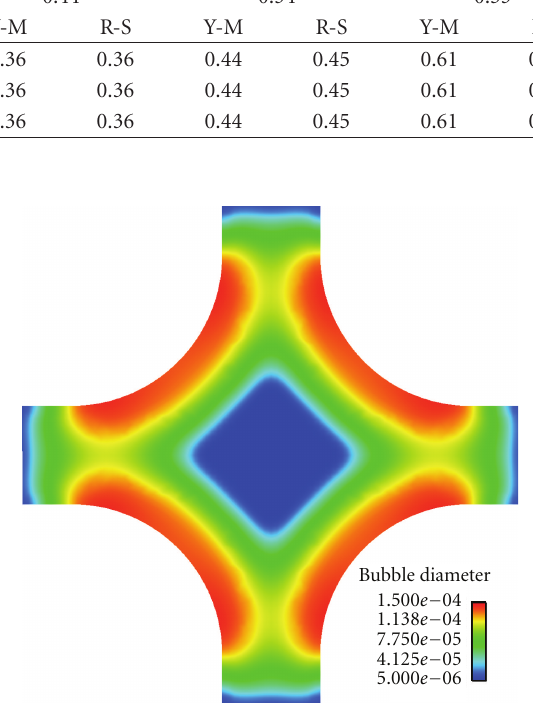
Figure 14: Bubble-diameter distribution at the measuring section for run 1.2211 by using the Yao-Morel